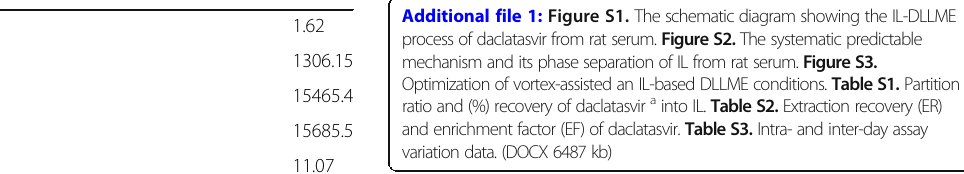
Table 5 Pk data of daclatasvir Parameter